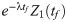
Simulation versus theory in the case of a path graph with 4 vertices, as in Fig 2.(a) Joined lines show a single realisation of the population growth obtained via simulation. Dashed lines are the asymptotic growth of the populations, which follows the functions given immediately above the dashed lines. These functions are a consequence of Theorem 3, which can be found in the Materials and Methods section. W is a random variable whose value will differ between simulations. Its value here is estimated by the realised value of e-λtfZ1(tf), with tf = 14.5. (b) The distribution of the hitting time for vertex 4: Joined lines show the empirical distribution obtained from 1000 realisations, dashed lines display the theoretical approximation (5). The error in the approximation decreases as ν → 0, but still shows good agreement for moderate values of ν. (c) Probability density function for hitting time of vertex 4, conditioned that it is finite: bars display normalised histogram constructed from 1000 realisations, while dashed line shows approximation which follows from differentiating the conditional variant of (5) (given in Eq. S79 of S1 Appendix). The approximate median time for the type 4 population to arise, as given (9), is indicated by the red vertical line. Parameters: α = α(2) = α(3) = α(4) = 1, β = 0.4, β(2) = β(3) = 1.3, β(4) = 0.6, z = 1; for (a) and (c), ν(1, 2) = ν(2, 3) = ν(3, 4) = 0.05; for (b), legend displays value of ν = ν(1, 2) = ν(2, 3) = ν(3, 4) used.